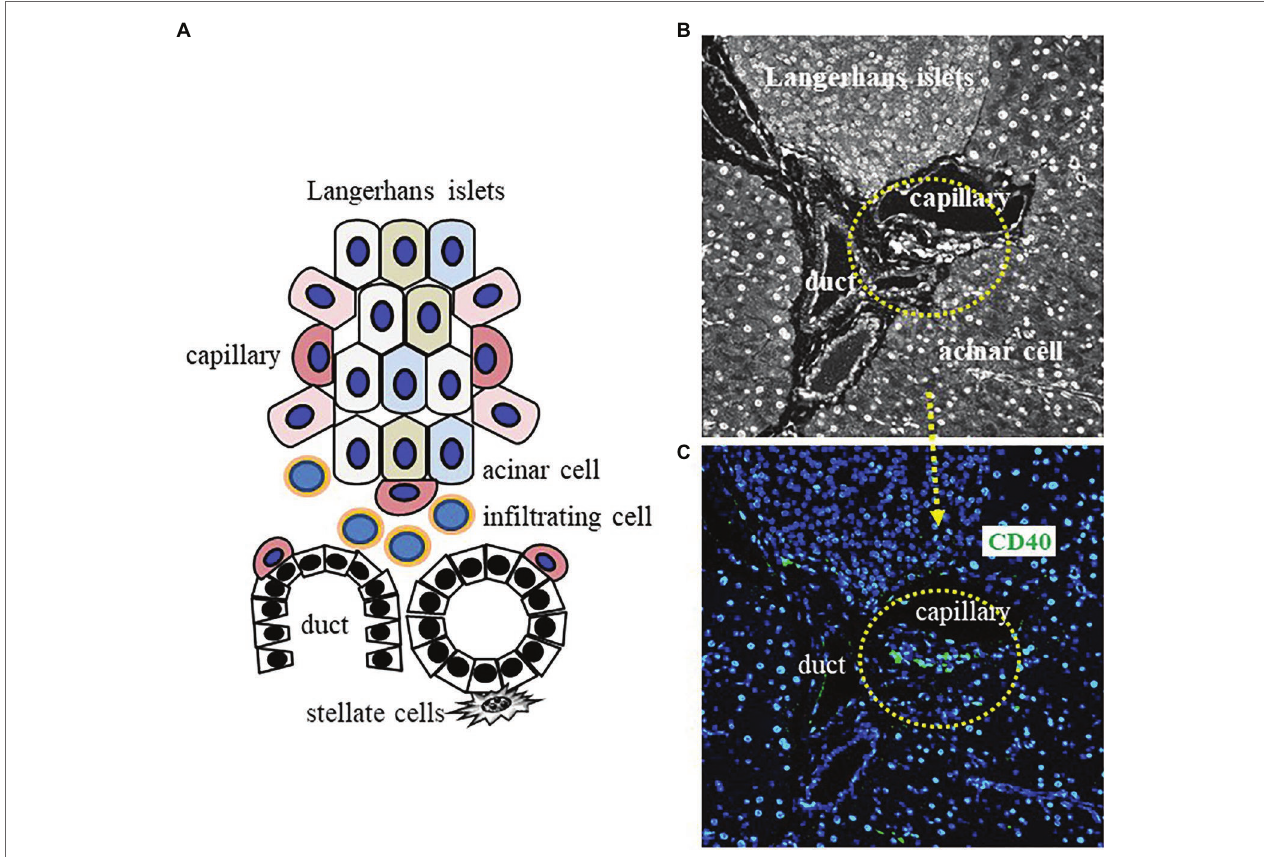
FIGURE 5 | Schematic image of inflammation in old patients with pancreatitis. Cell–cell interactions between stellate cells, capillary cells, and infiltrating CD40 + cells beside duct of pancreas of elderly pancreatitis patients induce the activation of pancreatic stellate cells (PSCs) for chronic inflammation and fibrosis. (A) Interaction model of senescence cells in pancreas. (B,C) Infiltrating CD40 + cells into duct interacts with PSCs during SASP-induced chronic inflammation in a disease-specific